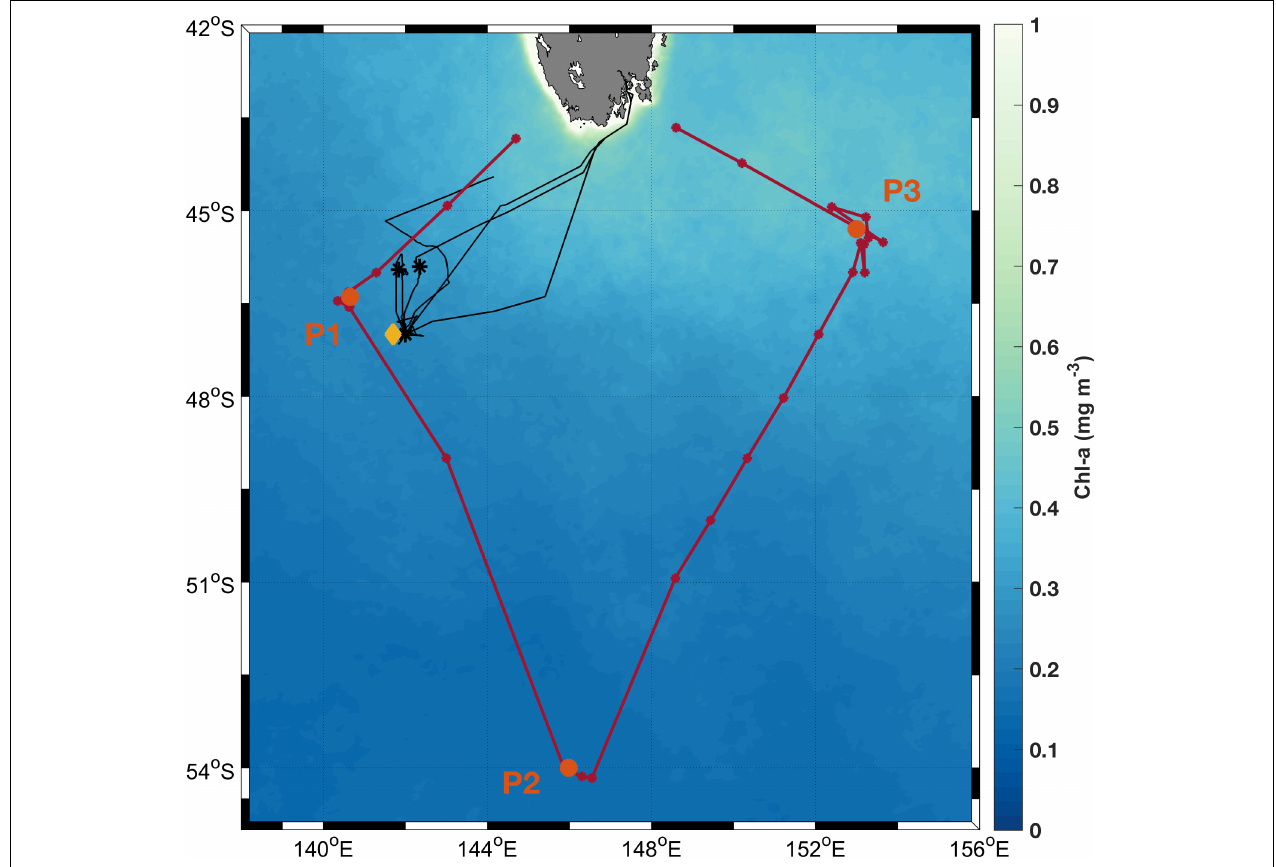
FIGURE 1 | Map with SOTS location (yellow diamond), SAZ cruise track and CTD stations (red), and SOTS 2018 cruise track and CTD locations (black). Process stations P1, P2, and P3 from the SAZ-Sense voyage are indicated in orange. Background color scale indicates mean Chl concentrations (mg m − 3 ) for the duration of Aqua-MODIS mission (12+